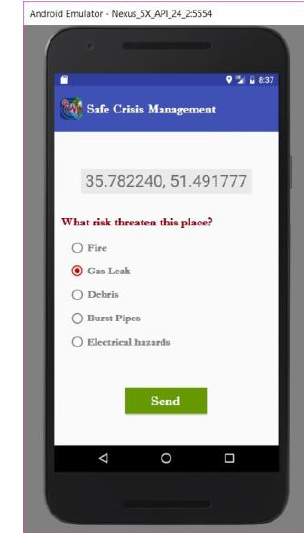
Figure 17. Determine the damage